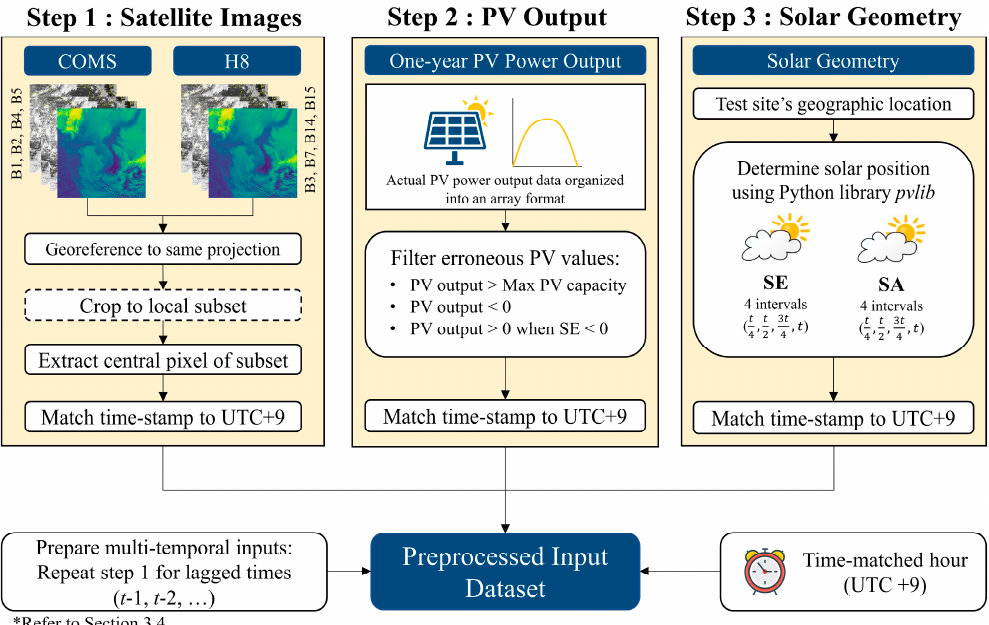
Figure 6. Detailed flowchart of the preprocessing steps for each input variable required to prepare